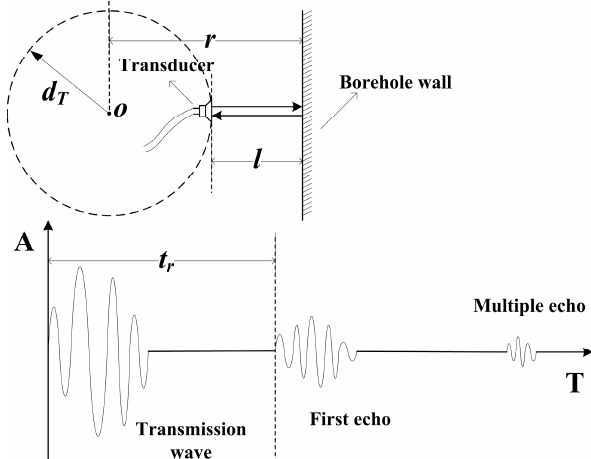
Figure 2. Principle diagram of the pulse-echo mode ultrasonic distance measurement system. O is the tool axis, d T is the distance between the tool axis and the transducer, l is distance between the transducer and the borehole wall, and t r is the arrival time of the first echo.